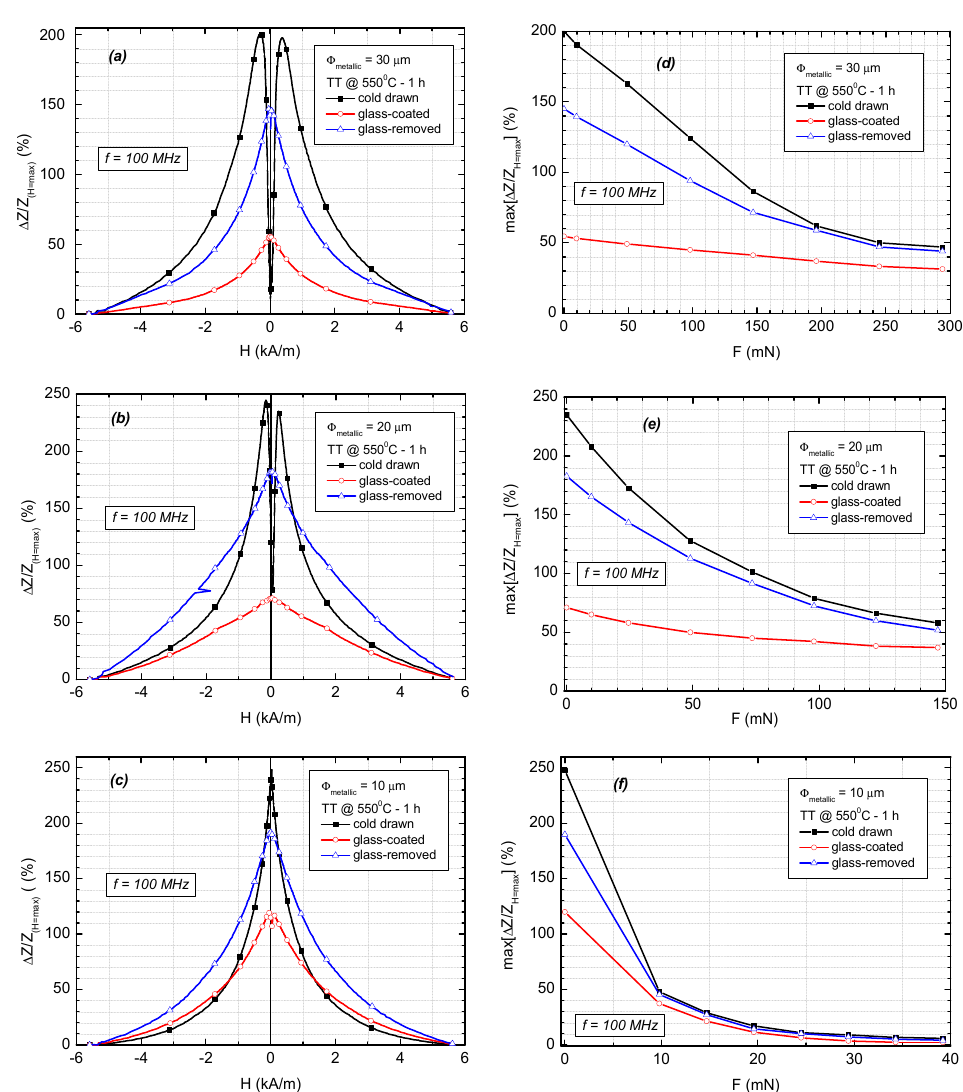
Figure 6. Relative variation of the impedance versus axially applied magnetic field ( a – c ) and its maximum value versus applied tensile force ( d – f ), measured on annealed (550 ◦ C—1 h) Fe 73.5 Si 13.5 B 9 Cu 1 Nb 3 cold-drawn, glass-coated, and glass-removed microwires, with 30 µ m, 20 µ m, and 10 µ m metallic core diameters, respectively. Sample length, l s = 15